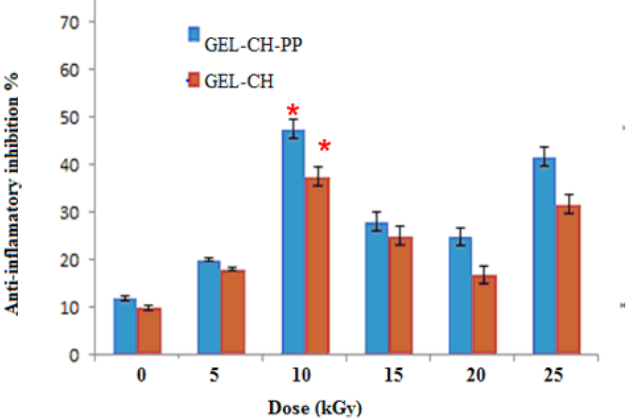
Figure 5. Determination of in vitro anti-inflammatory properties of gelatine – chitosan – Pomegranate peel (GEL–CH–PP) composite with different γ -radiation doses, 5, 10, 15, 20, and 25 kGy, in comparison with control samples (0 kGy). * Significant difference in the indicated group, as compared to the other groups for GEL–CH–PP ( p < 0.01) and GEL–CH ( p < 0.05).